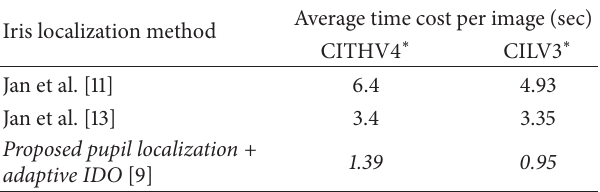
Table 2: Iris localization (pupil + iris’s outer boundary detection)